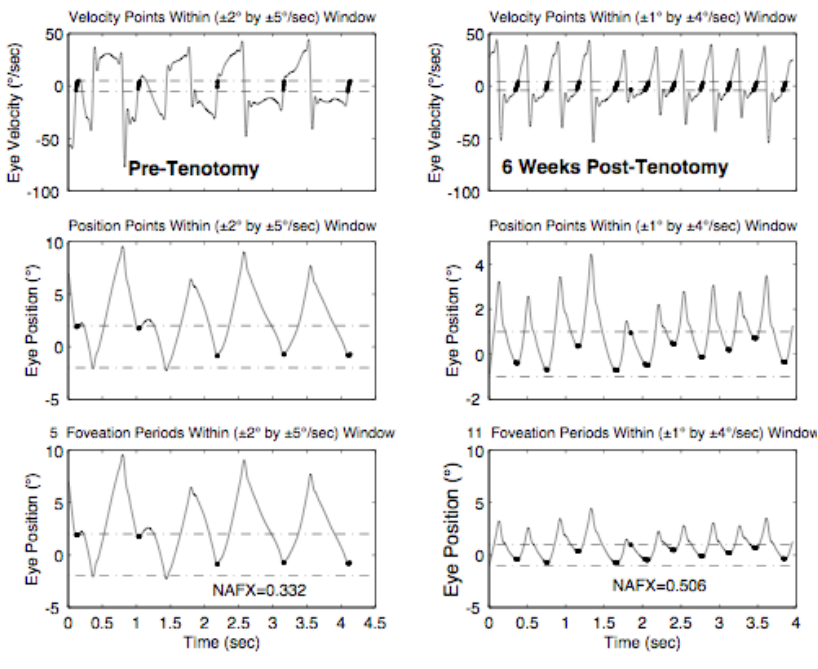
FIGURE 5. The output of the NAFX program showing the post-tenotomy improvement over the pretenotomy value. Post-tenotomy, the foveation periods (shown thickened) were more numerous per unit time and of longer duration resulting in a higher